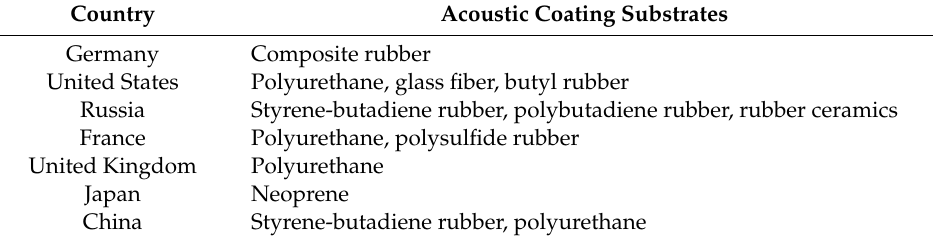
Figure 3. Conventional design process of acoustic coatings [10]. Table 1. Substrate materials of acoustic coatings [11].